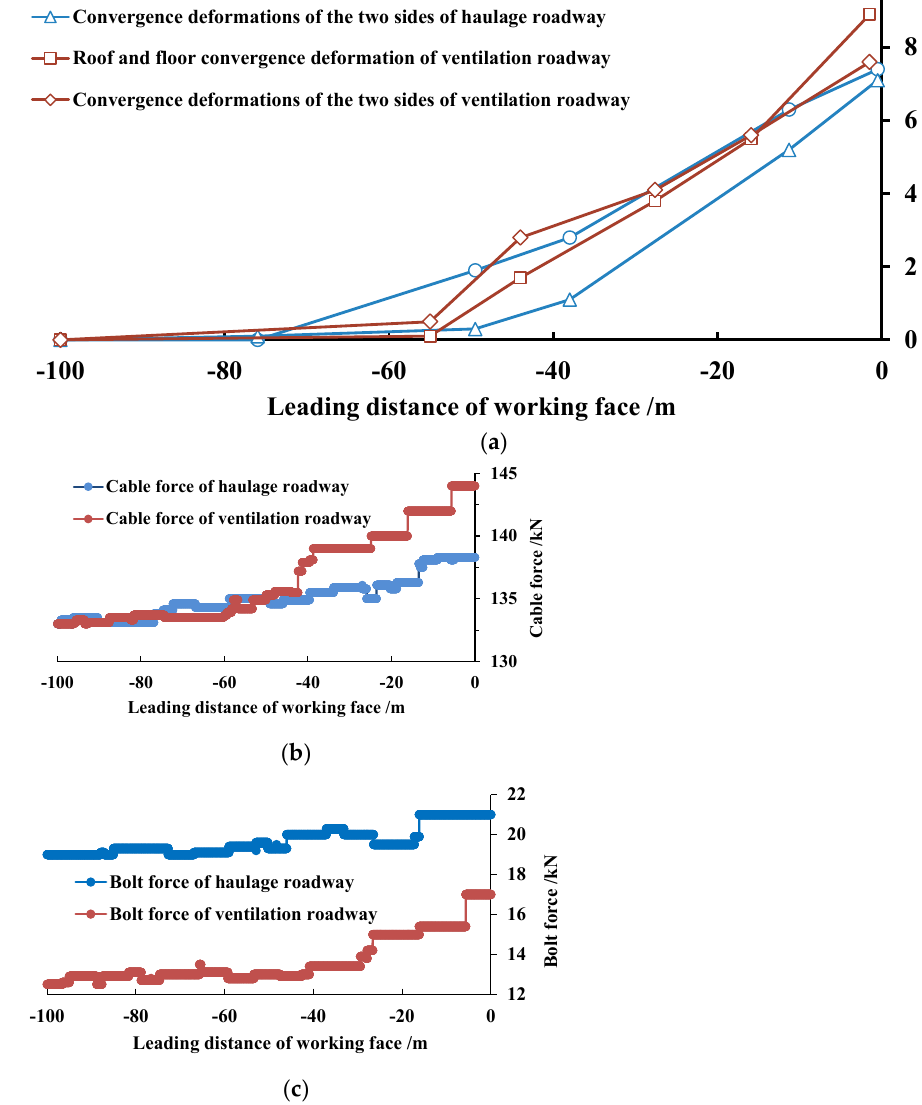
Figure 3. Roadway surrounding rock monitoring within the advance pressure influence range. ( a ) Displacement curve of the surrounding rock. ( b ) Force variation curve of the anchor cable. ( c ) Force variation curve of the bolt.